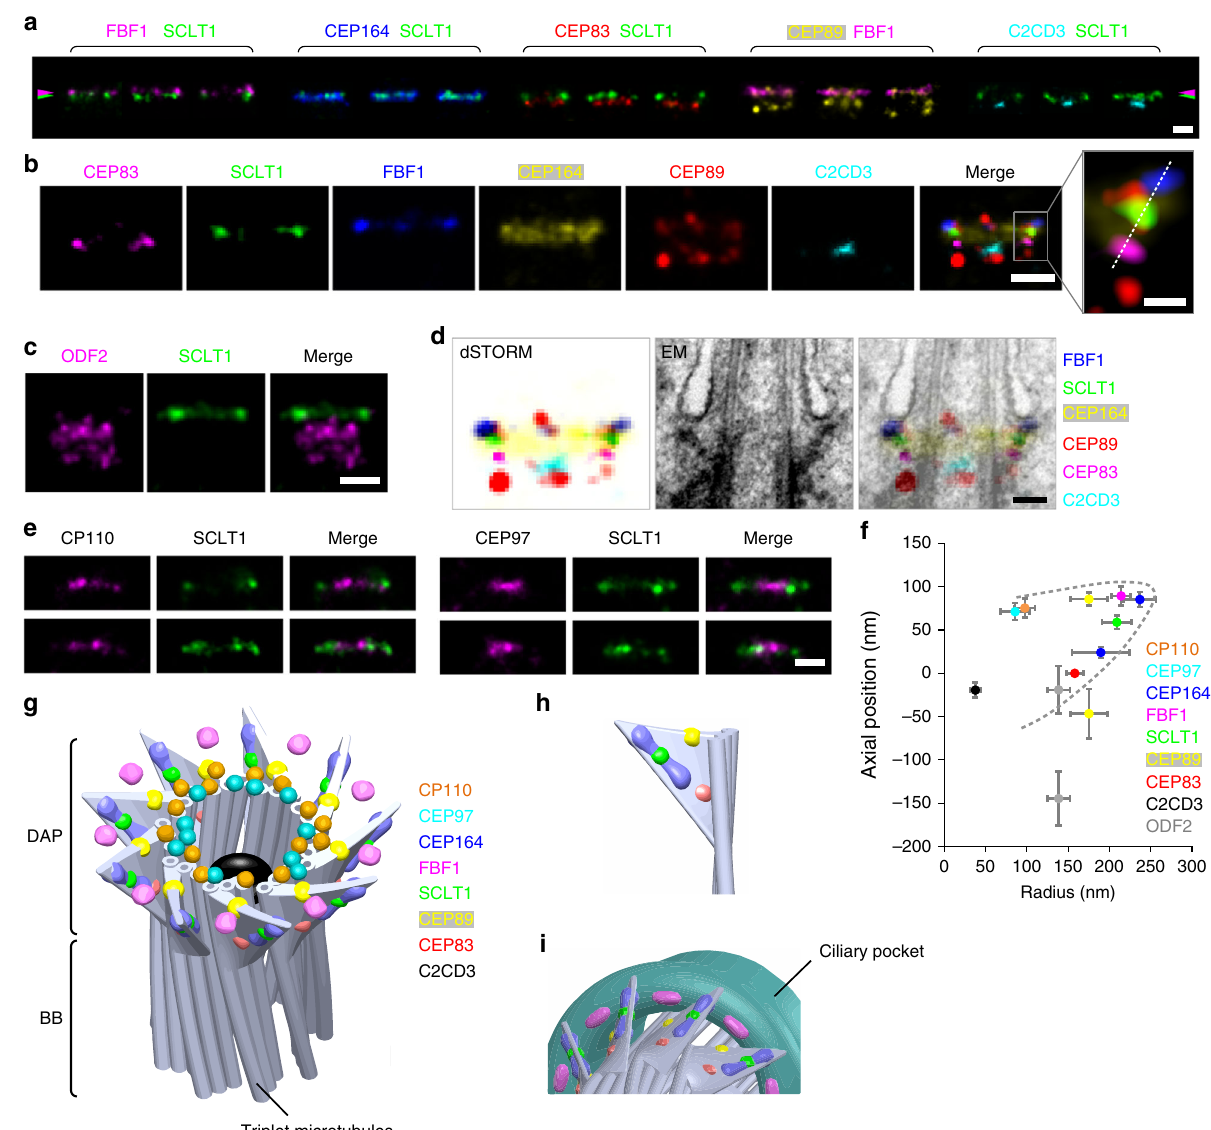
Fig. 3 Three-dimensional spatial map of distal appendage (DAP)-associated proteins. a Three representative two-color dSTORM images from a lateral view of each pair of DAP proteins illustrates their relative longitudinal positions. Pink and green arrowheads depict the heights of FBF1 and SCLT1, respectively. b Representative images of DAP proteins are aligned and combined according to their average longitudinal positions. The magni fi ed image (inset) demonstrates the mapping of DAP proteins on the tilted arrangement of the DAP structure (dashed line). c Super-resolved images of the subdistal appendage protein ODF2 reveal its two-layered localization at a far lower location than that of SCLT1. d Merged super-resolution image in b overlaid with a longitudinally sliced EM micrograph. CEP83, SCLT1, and FBF1 are well aligned with the electron density of the slanted DAPs. e CP110 and CEP97 are localized longitudinally, similar to SCLT1, but with a narrower lateral width. f Combined relative localization of DAP-associated proteins in radial and longitudinal directions, revealing the envelope of the slanted arrangement of a DAP blade (dotted line). The results (presented as mean ± SD) and the numbers of measured points are summarized in Supplementary Table 1. g A 3D computational model illustrating the positioning of proteins at the DAP region with a backbone structure based on EM 10 . h CEP164, CEP83, SCLT1, and the distal layer of CEP89 mapped onto a blade of the 3D-reconstructed DAPs. i FBF1 localizes to gaps between two adjacent DAP blades, possibly at the proximal boundary of the ciliary pocket. Bars a , b (left), c , and e = 200 nm; b (inset) = 50